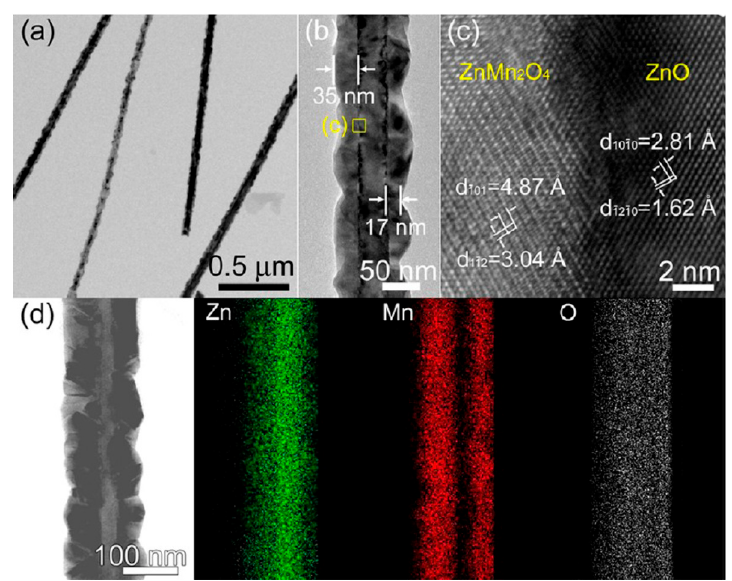
Figure 8. Morphologies and crystal structures of ZnO-ZnMn 2 O 4 NCs: ( a ) and ( b ) TEM images of ZnO-ZnMn 2 O 4 NCs grown on Si substrates. ( c ) Lattice-resolved image of ZnO-ZnMn 2 O 4 NCs. ( d ) Energy dispersive X-ray spectroscopy (EDS) elemental mapping of Zn, Mn, and O. Reprinted from [84] with permission. Copyright (2012) American Chemical Society.